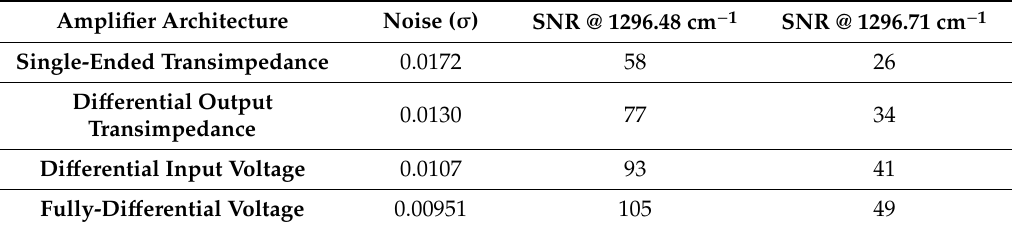
Table 1. Quartz-enhanced photoacoustic spectroscopy (QEPAS) 1σ noise and signal-to-noise ratio calculated for water vapor absorption features falling at 1296.48 and 1296.71 cm −1 when implementing the four different amplifier architectures.